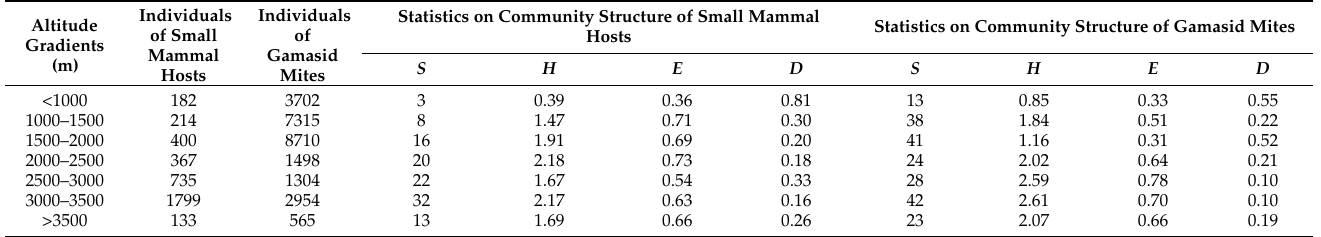
Figure 2. Species richness (number of species) variations of gamasid mites and their small mammal hosts along altitude gradients in Three Parallel Rivers Area in northwest Yunnan of China (2001 – 2015). Table 5. Statistics on community structure of small mammal hosts and gamasid mites along different altitude gradients in Three Parallel Rivers Area in northwest Yunnan of China (2001–2015).